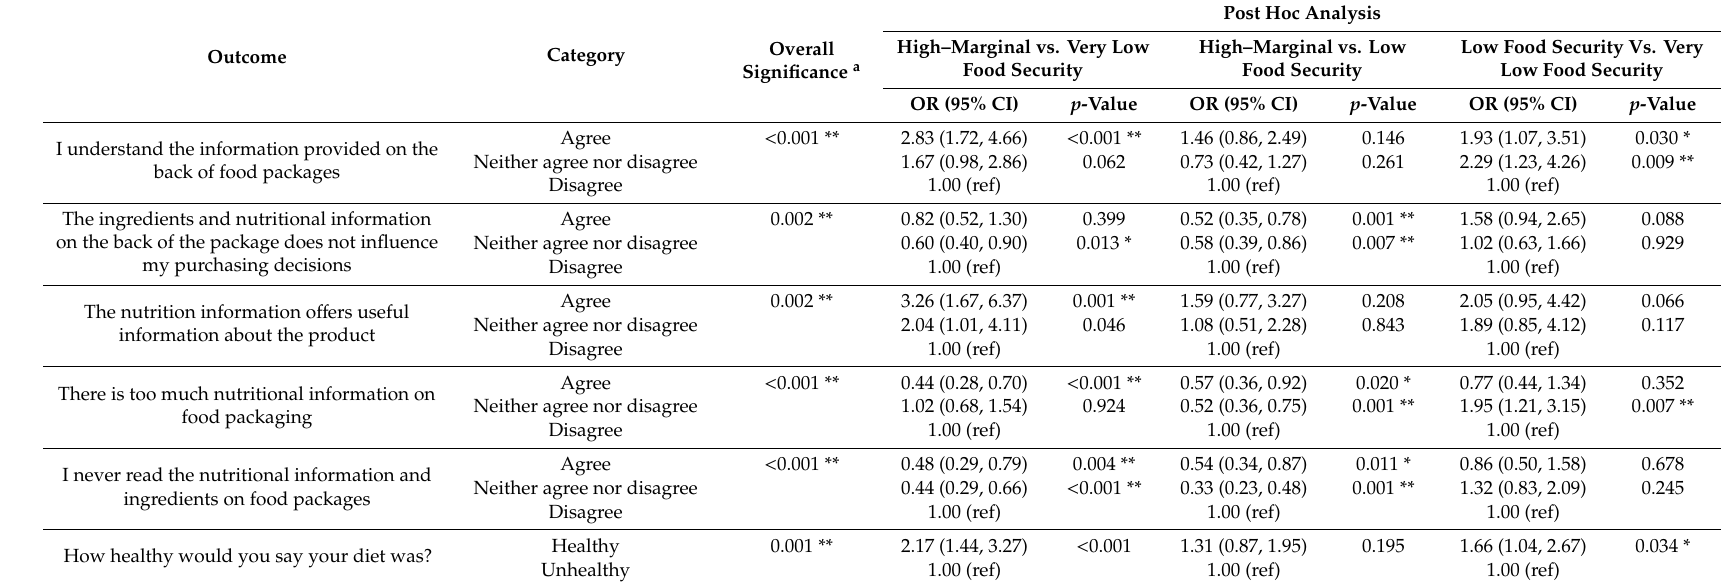
Table 2. Significant food label and single consumption indicators. a